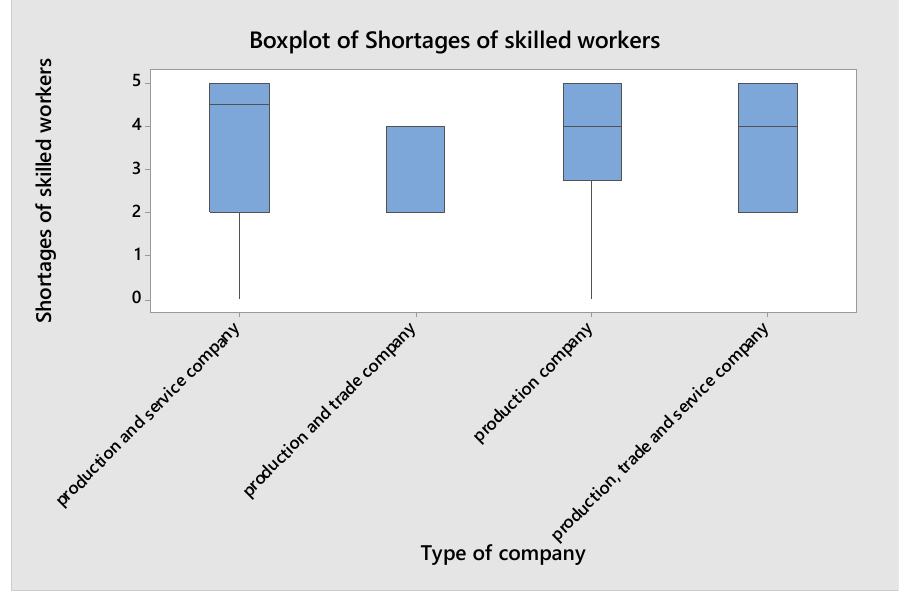
Figure 7. Box plot: comparison of the importance of the shortages of skilled workers indicator for manufacturing companies, depending on their type.